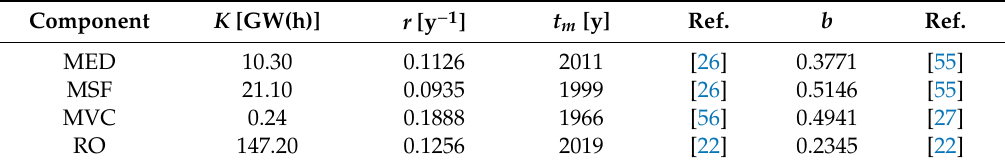
Table 5. Future cost parameters of desalination